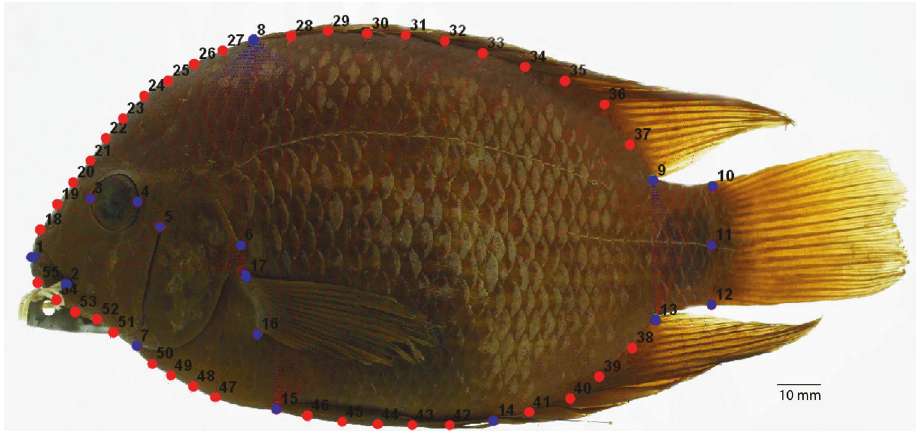
FIGURE 2 | Landmarks (in blue) and semilandmarks (in red) as placed on each specimen. Landmark positions are described on Tab. S1